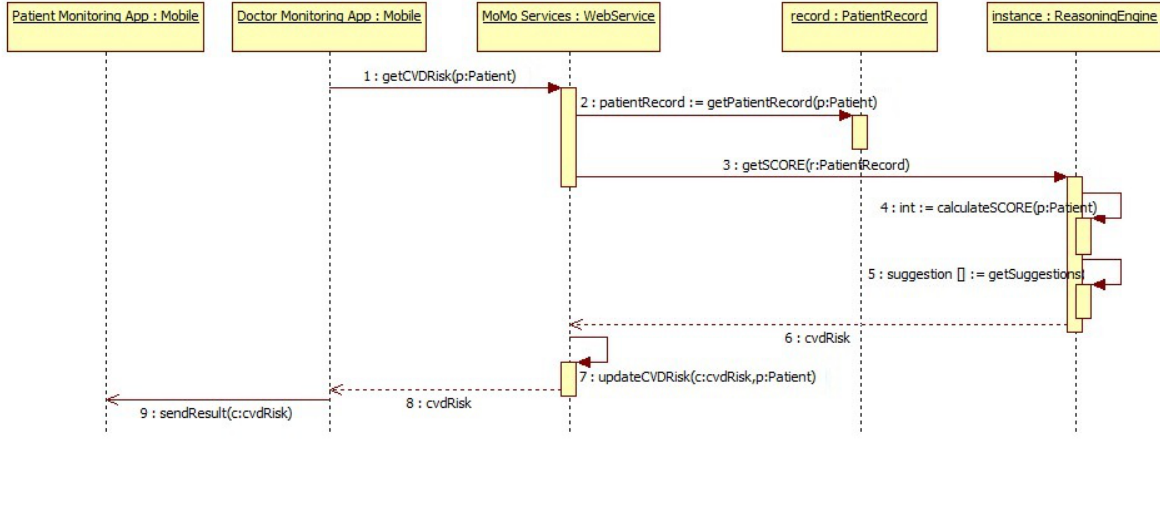
Figure 2. Sequence diagram: CVD Risk